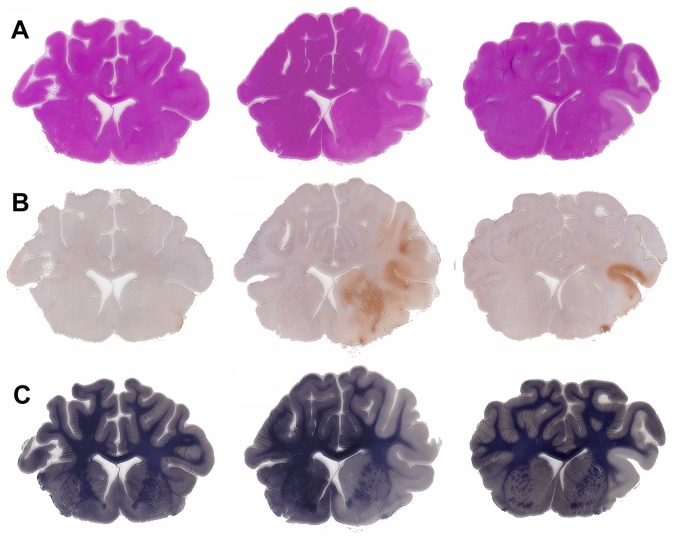
Histopathology.(A) H&E stain for sham (left), permanent MCAO (center), temporary MCAO (right). (B) Albumin immunostain for sham (left), permanent MCAO (centre), temporary MCAO (right). Weil stain for sham (left), permanent MCAO (centre), temporary MCAO (right). MCAO, middle cerebral artery occlusion.